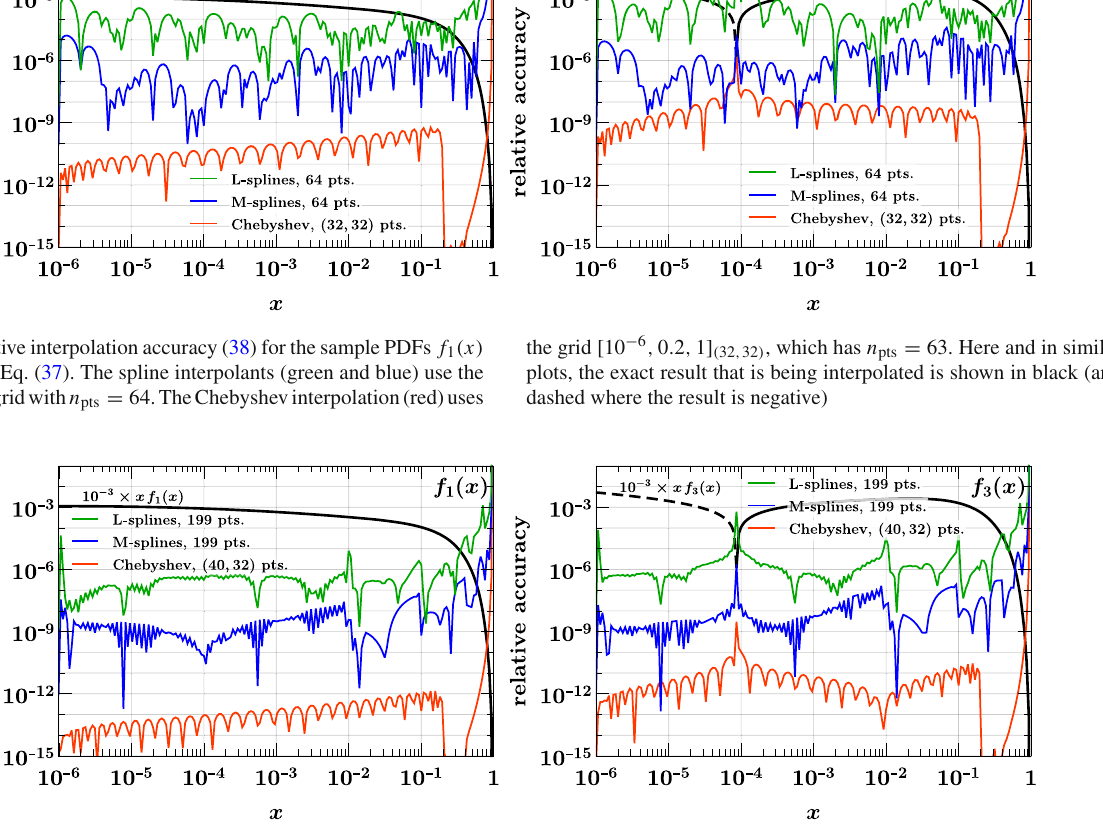
Fig. 2 As Fig. 1, but for denser grids. The spline interpolants (green and blue) use the high-density grid with n pts = 199. The Chebyshev interpolation (red) uses the grid [ 10 − 6 , 0 . 2 , 1 ] ( 40 , 32 ) , which has n pts =